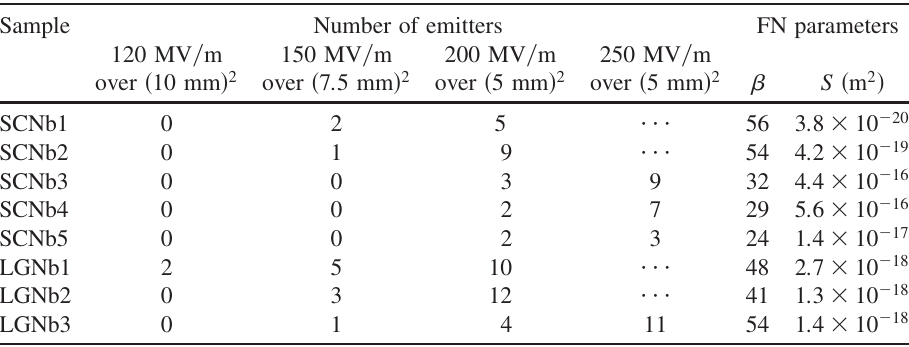
TABLE II. Emitters observed in FE maps of all Nb samples (see Table I) at different field levels and the typical (cid:3) and S values retrieved from local I-V measurements of emitters.